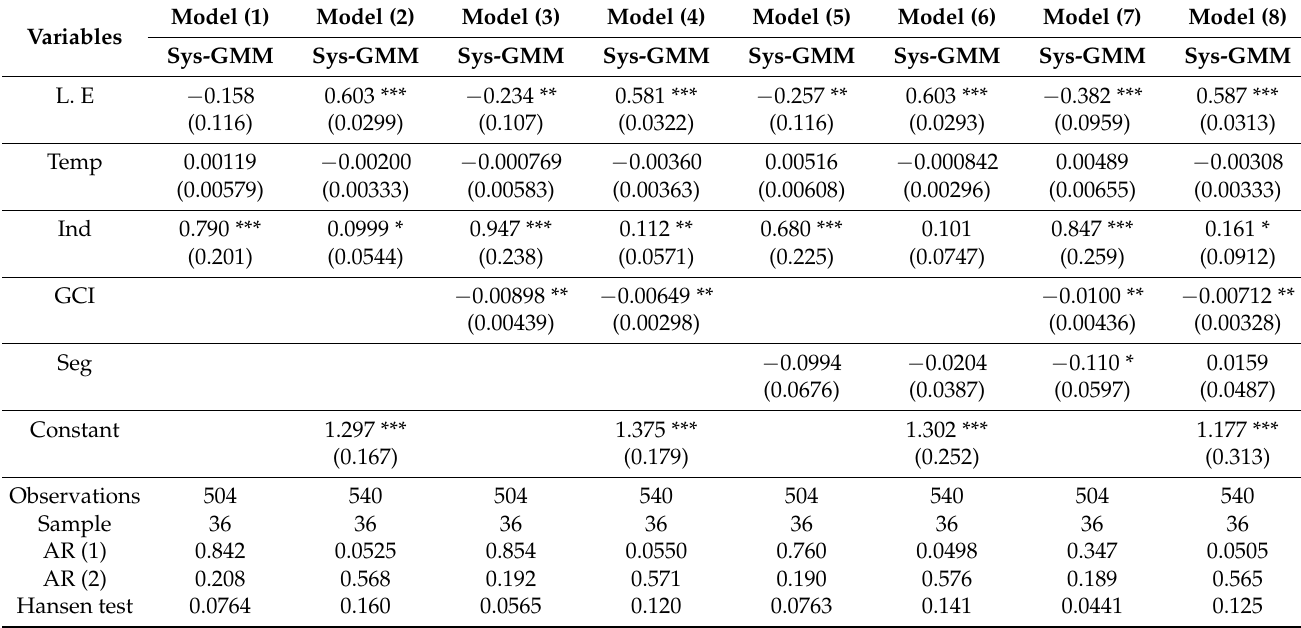
Table 6. The energy consumption function